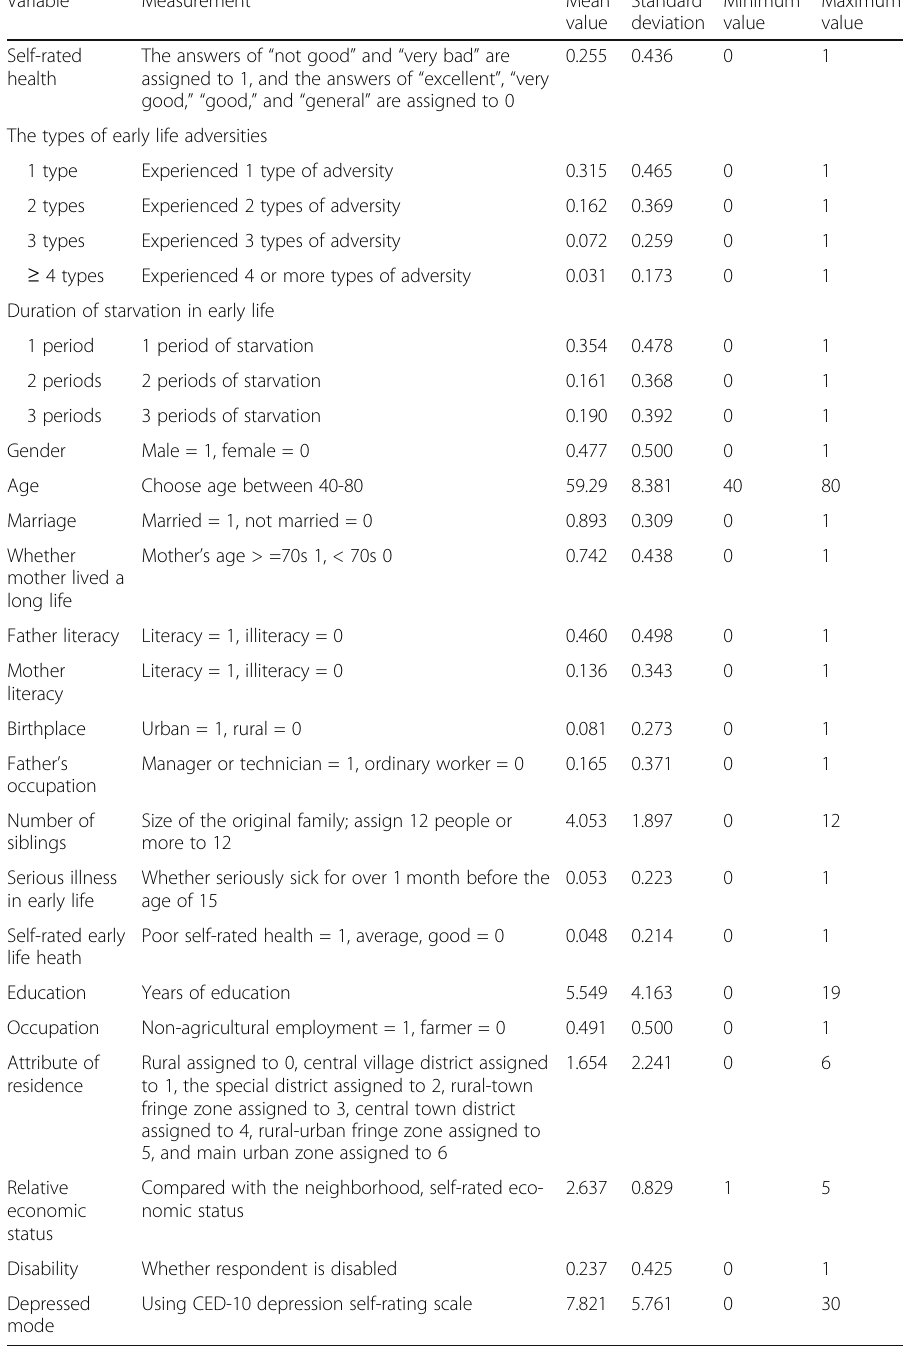
Table 1 Variable introduction and description statistics ( N = 9701)